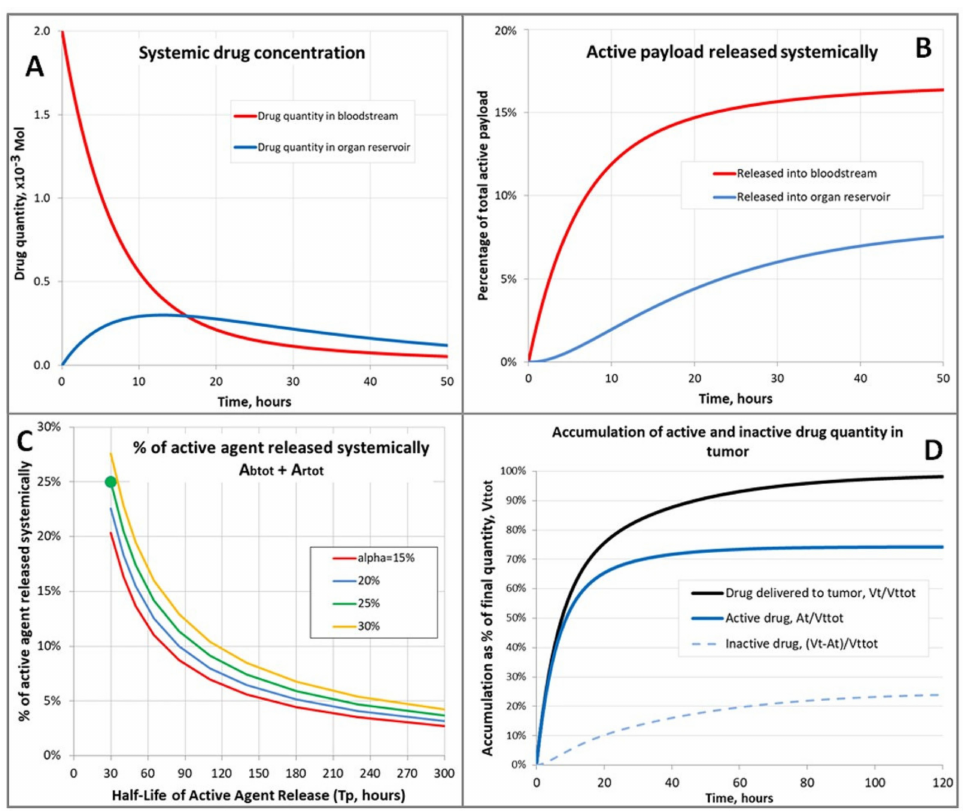
Figure 5. Model of drug release and active agent accumulation. Input parameters ( T b , T r , T p , V ) are per the example in the text. ( A ) Systemic drug concentration; ( B ) Active payload released sys-temically; ( C ) % of active released systemically; ( D ) Accumulation of active and inactive drug quantity in tumor. In panel ( C ), T p varies–the green dot shows the example given in the